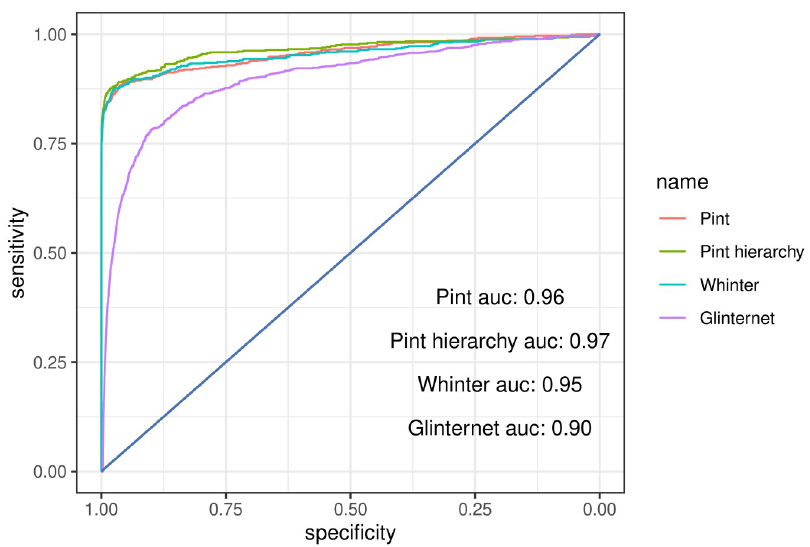
Fig 6. Receiver operating characteristic curve comparing fraction of reported effects that are true positives as the predicted strength varies in the p = 4, 000 simulations.